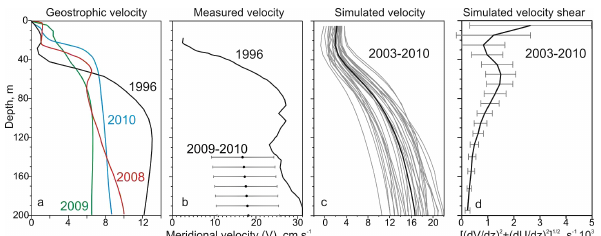
Figure 7. Vertical velocity profiles for the northward current over the ST eastern flank: (a) geostrophic, (b) measured and (c) simu- lated for each grid node over the ST eastern flank between 78 and 81 ◦ N (gray lines, averaged for 2003–2010 using annual mean ve- locity profiles) with their mean (black line). (d) Vertical profile of the simulated velocity shear at the mooring position averaged for 2003–2010 using daily mean velocity profiles. (b, d) Error bars show 1 standard deviation from the mean.